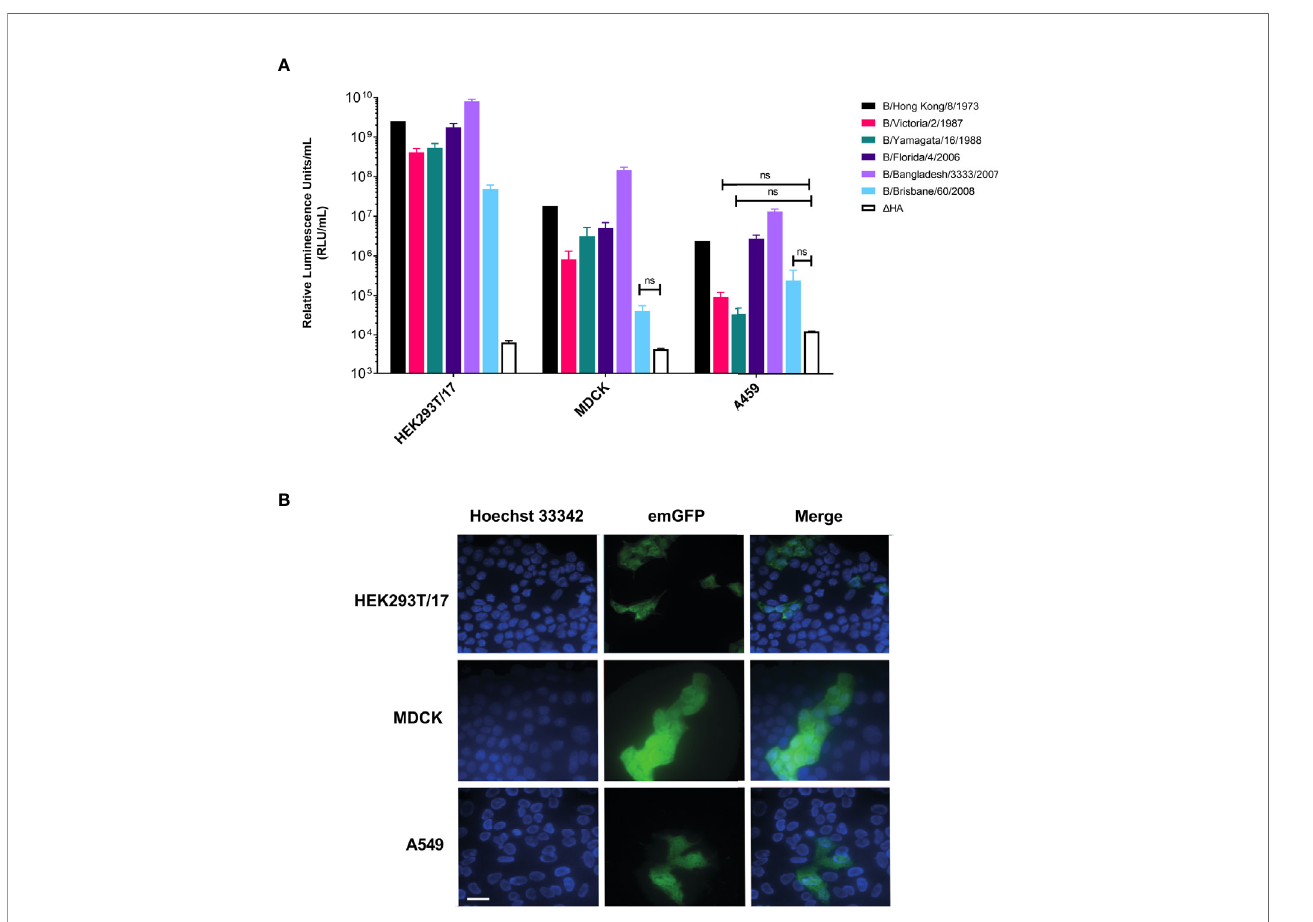
FIGURE 3 | In fl uenza B pseudotypes are expressed in different cell lines. (A) Titers of in fl uenza B pseudotypes expressing fi re fl y luciferase in HEK293T/17, MDCK, and A549 cells are shown in RLU/mL as the mean and standard deviation of 4 replicates. A D HA control representing non-HA pseudotyped virus was included for comparisons. No signi fi cant difference between PV titers and D HA is indicated by brackets ( n.s. p>0.05 ). (B) In fl uenza B lentiviral pseudotype B/Florida/4/2006 containing an emerald GFP reporter is shown to successfully transduce HEK293T/17, MDCK and A549 cells. Scale bar = 6